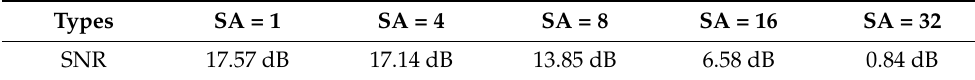
Table 2. SNR of the US imaging based on the different aperture